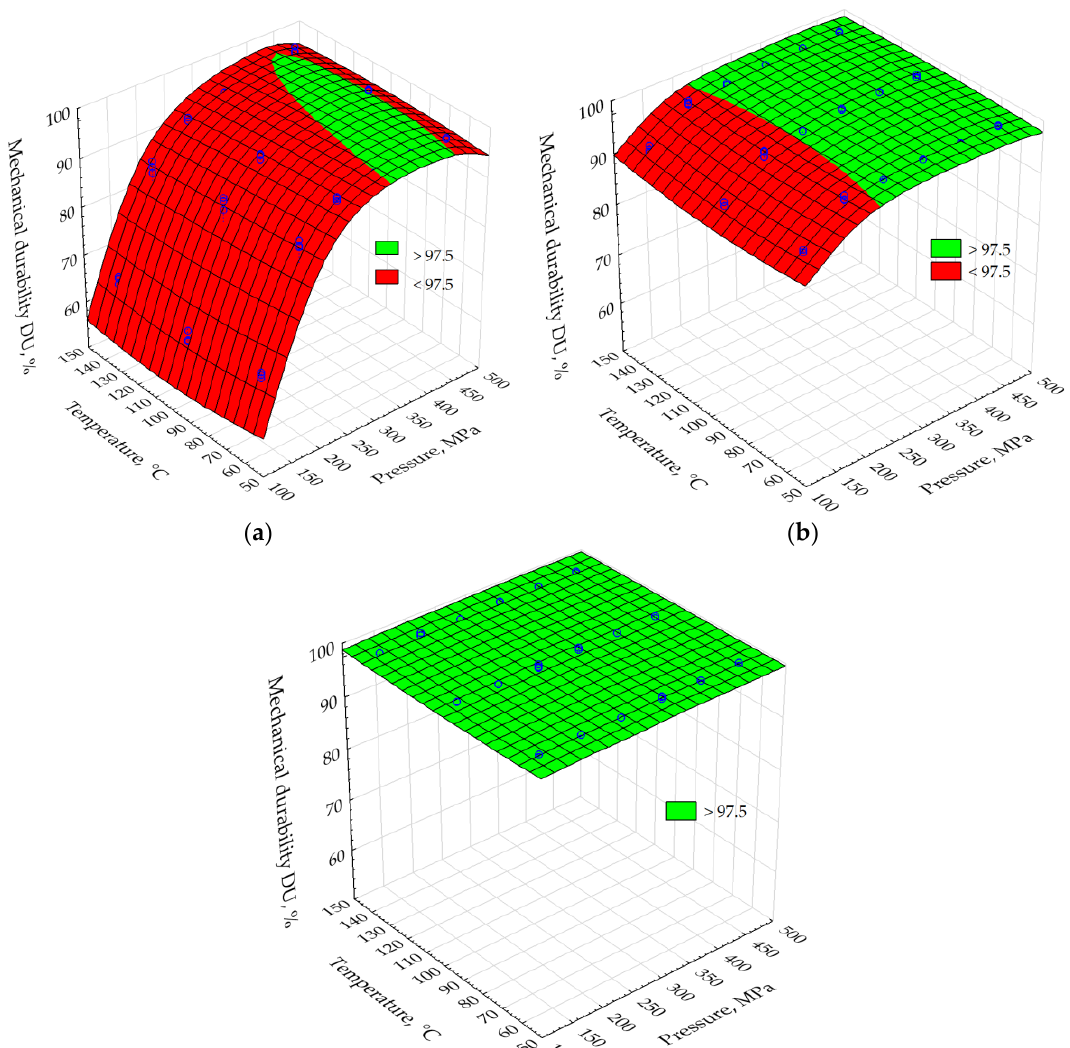
Figure 7. Pellet mechanical durability ( DU) changes as a function of the raw material drying temperature and densification pressure: ( a ) raw material in dry state, ( b ) 5% moisture content, ( c ) 10% moisture content.